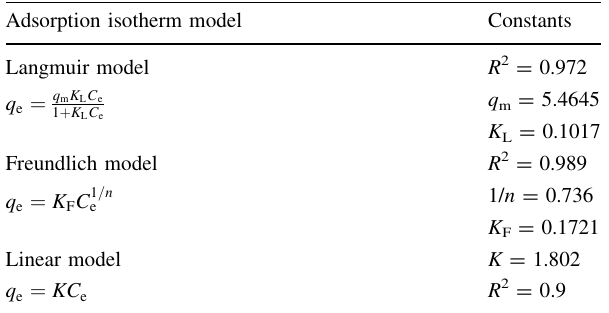
Table 8 Values of thermodynamic